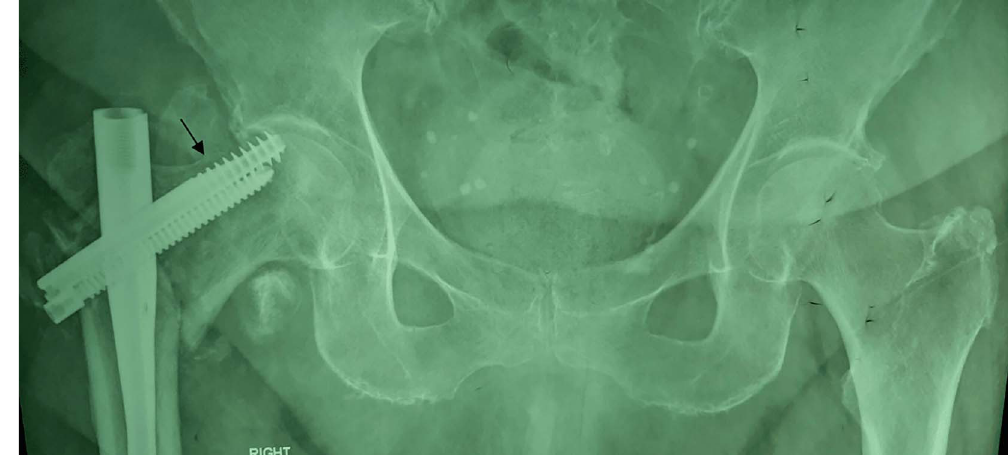
Figure 2. Lag screw cut-out 3 months